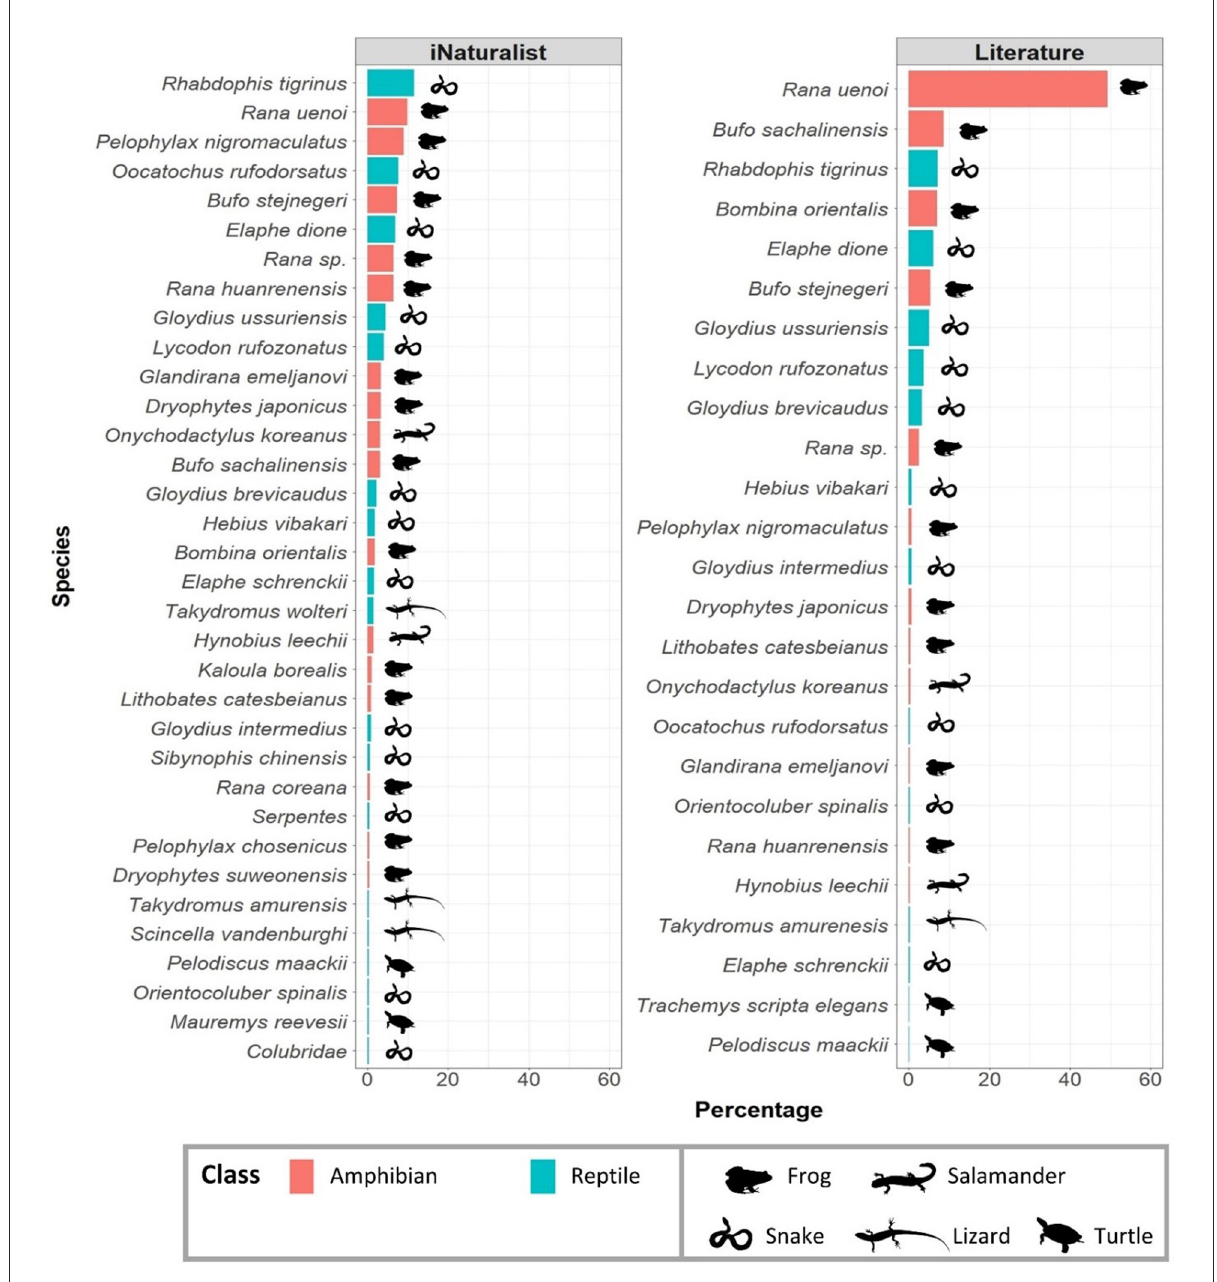
FIGURE4 Comparison of the taxonomic composition of roadkill observations between the iNaturalist and literature-based data. Due to the different sample sizes between data types, we converted the raw count of frequency to percentages to apply the same scale of comparison. The most heavily affected species were generally congruent between datasets, with several differences associated with taxonomic diversity detected in each dataset as well as the sampled percentage of each species. Note that the iNaturalist data detected roadkills in more species ( n 32; 76.2% = of total herpetofaunal diversity of R Korea) compared to the literature-based data ( n 25; 59.5% of total herpetofaunal diversity of R Korea). The = silhouette figures were obtained from PhyloPic (http://phylopic.org/) under the Public Domain Dedication 1.0 license or the Public Domain Mark 1.0 license (for the turtle silhouette). Frog silhouette ( Leptodactylus melanonotus ) by Jose Carlos Arenas-Monroy; Salamander silhouette ( Onychodactylus fischeri ) by zoosnow; Snake silhouette ( Vipera berus ) by Beth Reinke; Lizard silhouette ( Eumeces fasciatus ) by David Orr; Turtle silhouette ( Chrysemys picta ) by an uncredited